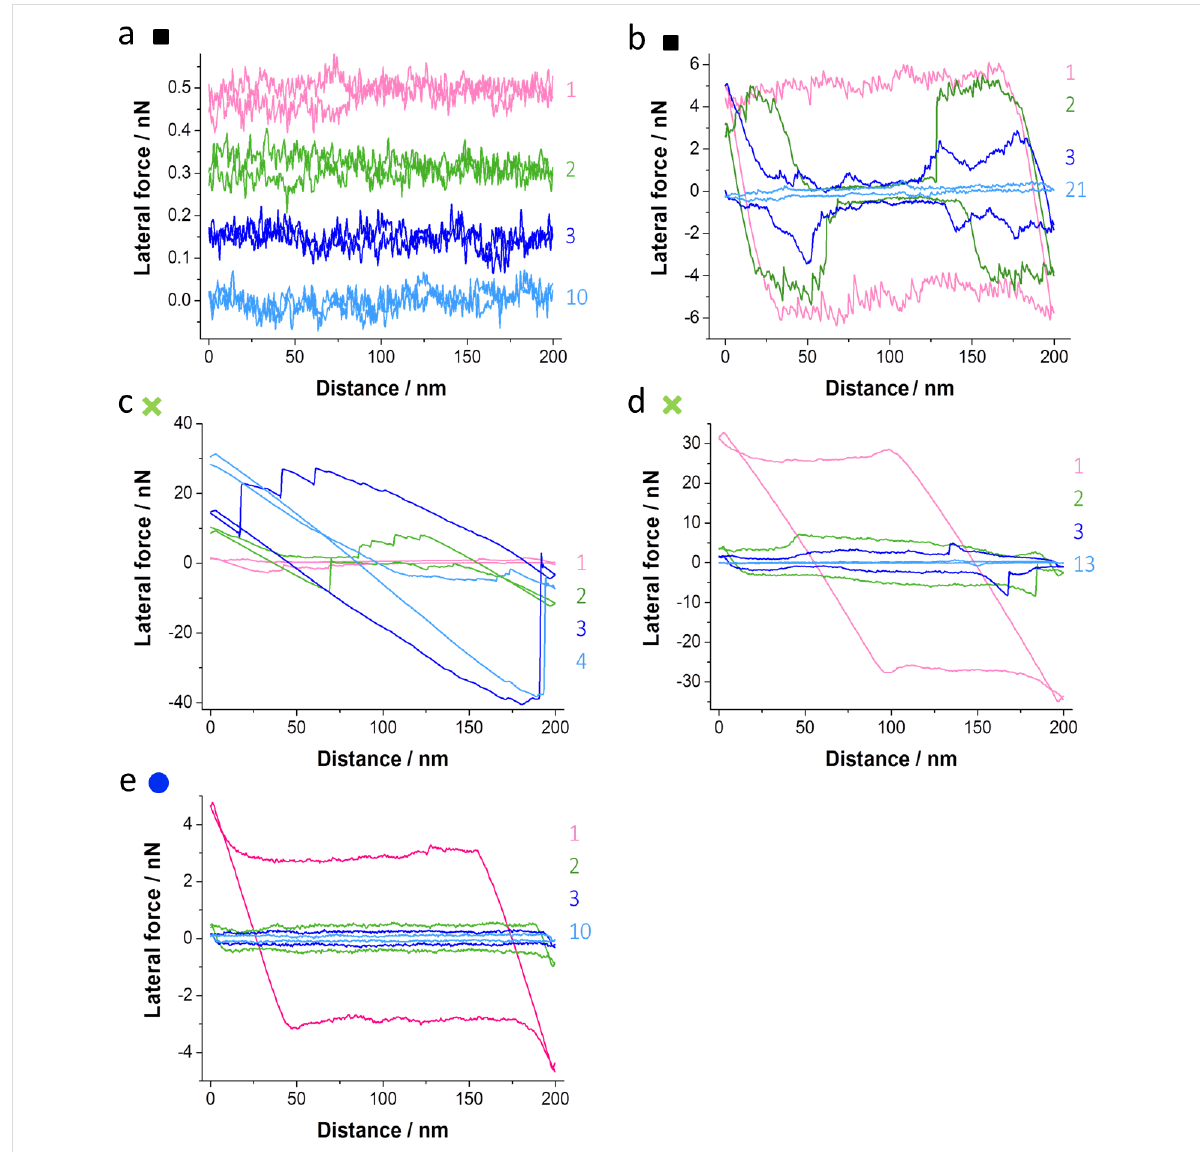
Figure 4: Lateral force loops of the same line from different scan frames. The respective scan number is indicated in the graphs. a) Au/Si tip–oxidized Si(100); friction was very low and decreased with scan frame. The curves are offset for clarity. b) Activated Au/Si tip–oxidized Si(100); the initially high and uniform friction decreased non-uniformly over the surface until it reached a low level and even distribution. c) SiO x /Si tip–reactive Si(100); the fric- tion increased unevenly with scan frame. d) Activated SiO x /Si tip–Au(111); the friction decreased from a very high level within 13 scan frames. e) Acti- vated Au/Si tip–Au(111); the friction decreased within ten scan frames and the lateral force remained uniform.